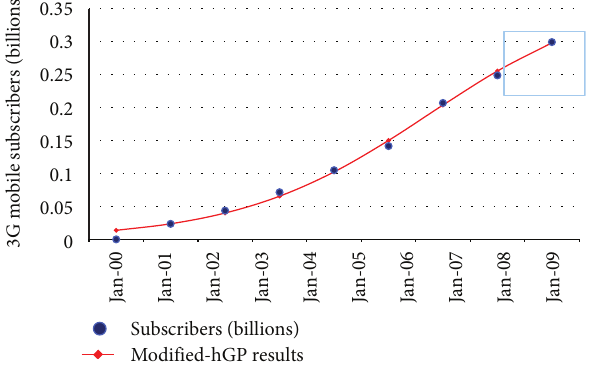
Figure 28: The forecasting performance of the modified-hGP (forecast window—2 years ahead) for the number of OECD mobile 3G subscribers.